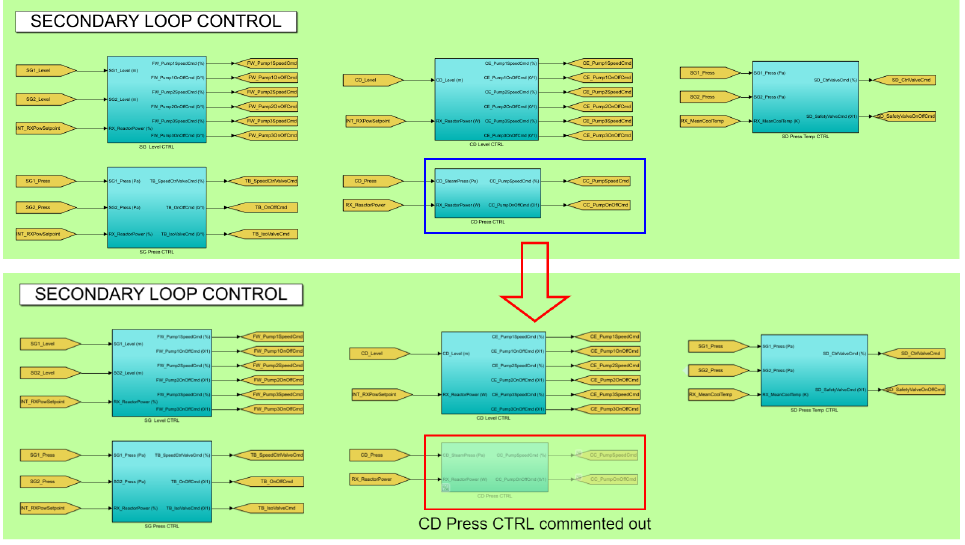
Figure 12. CD Press CTRL module commented out.